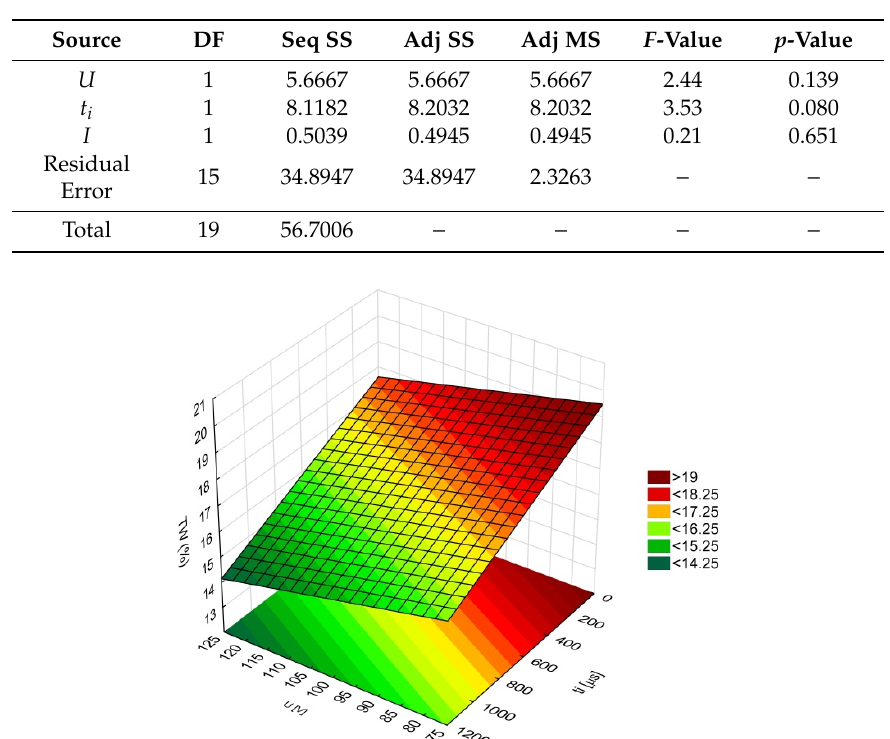
− Table 11. ANOVA for the surface roughness parameter Rz . Source